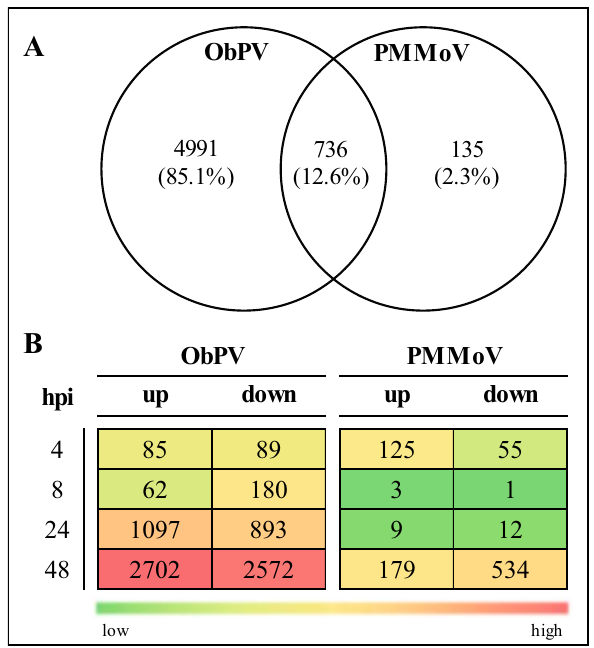
Figure 2. Distribution of differentially expressed genes (DEGs) in pepper leaves following inoculations with Obuda pepper virus (ObPV) and Pepper mild mottle virus (PMMoV). ( A ) Venn-diagram of all unique and common DEGs in ObPV- and PMMoV-inoculated pepper leaves. ( B ) Number of up- and down-regulated DEGs in ObPV- and PMMoV-inoculated pepper leaves at 4, 8, 24 and 48 h post-inoculation (hpi) as compared to the corresponding mock-inoculated samples (threshold values: p ≤ 0.01 and − 1 ≥ log2 fold change (FC) ≥ 1). Color scale corresponds to the number of